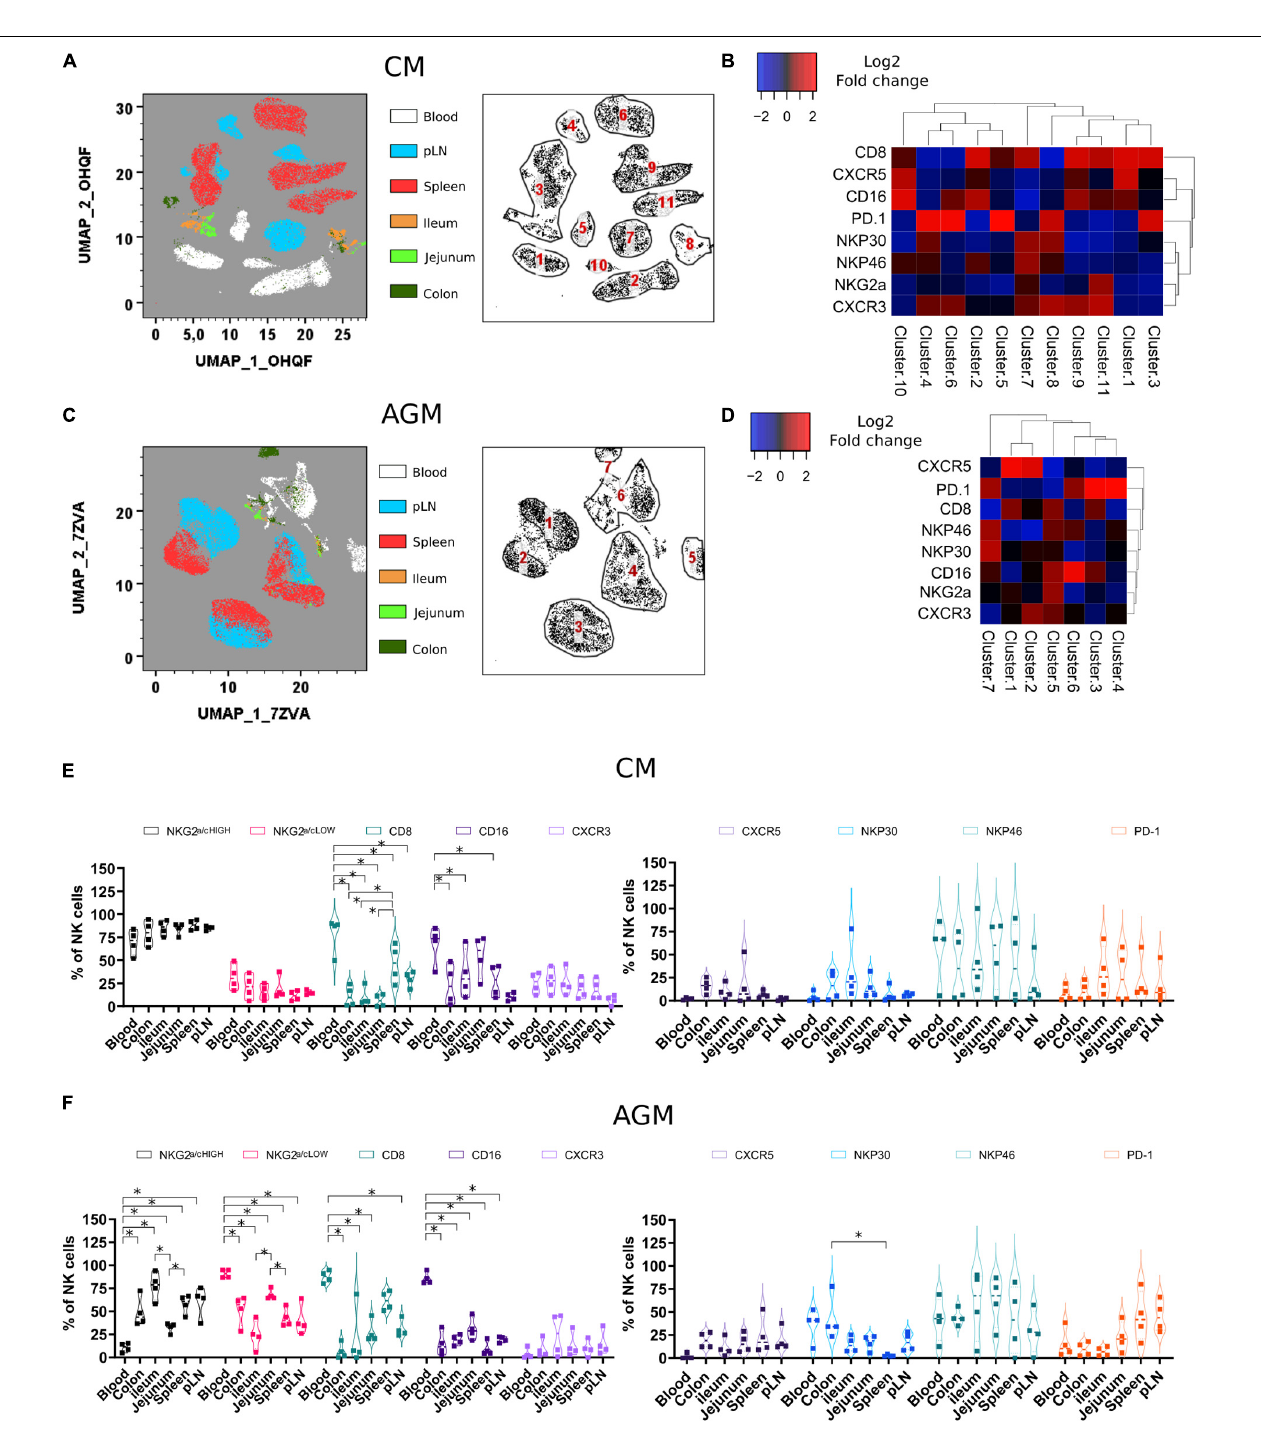
FIGURE 4 | Phenotypic analysis of NK cells during chronic SIV infection across different tissue sites. (A) Force-directed plot showing the relationship between NK cells from distinct tissues identified by multidimensional analysis (data compiled from five chronically infected CMs). Each node is an aggregation of similar cells resulting from the downsampling of data (left panel), and the collection of similar nodes forms 11 distinct NK cell clusters (right panel). (B) Heatmap showing the differential expression of cell surface markers used for clustering and community identification in the multidimensional analysis in panel (A) . (C) Same analyses as in panel (A) performed on four chronically infected AGMs. (D) Heatmap showing the differential expression of cell surface markers used for clustering and community identification in the multidimensional analysis in panel (C) . (E,F) Vioplots showing the distribution of markers on bulk tissue NK cells from four chronically SIV-infected CMs (E) and four chronically SIV-infected AGMs (F) . Each marker is presented with a unique color. All comparisons between NK cells were carried out using a one-way analysis of variance (ANOVA) and followed by a Tukey’s multiple-comparison test. The latter is a post hoc test based on the studentized range distribution. Median and standard error bars are shown. Asterisks indicate a p -value <